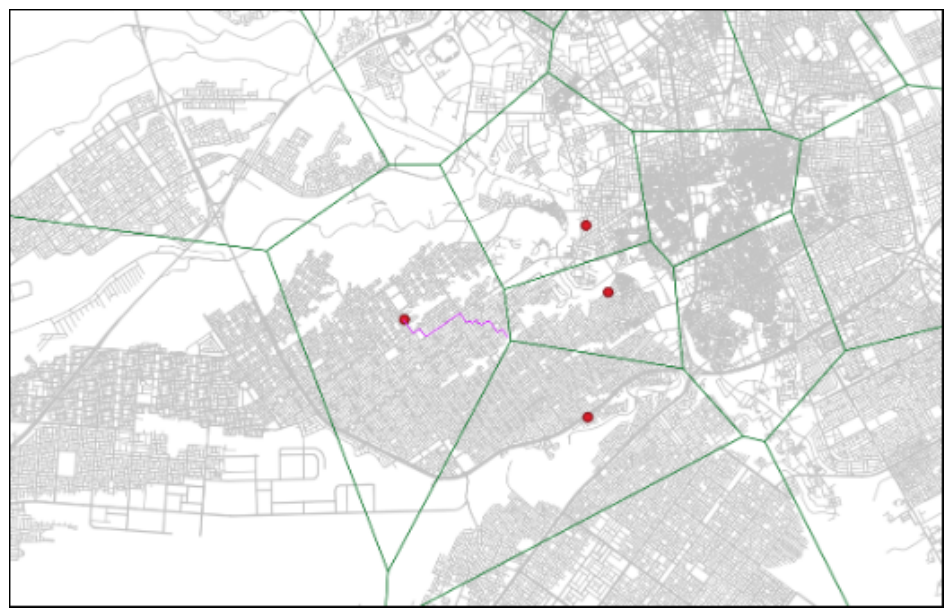
Figure 11. Ambulance emergency unit that has the minimum travel